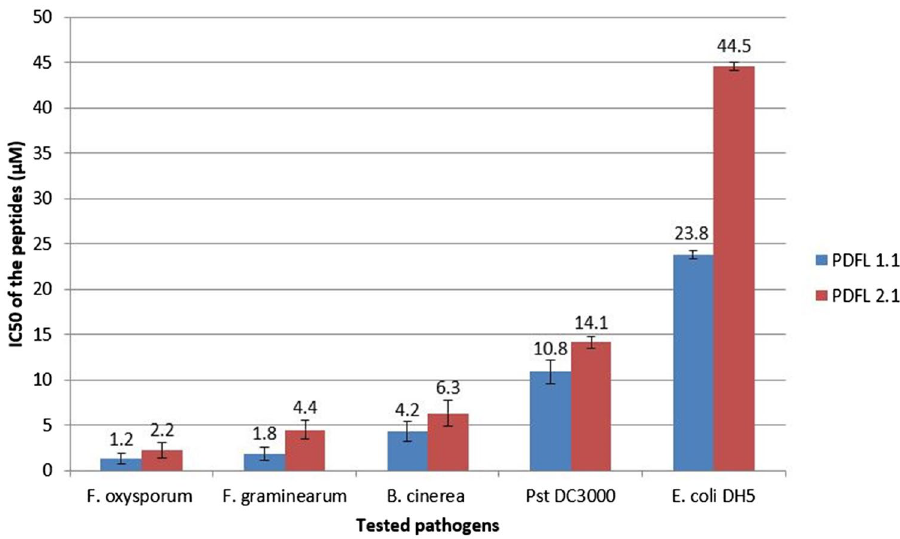
Figure 9. Comparison of the IC 50 of PDFL peptides against tested pathogens. The IC50 was determined in triplicate assays as described in “Materials and methods”.